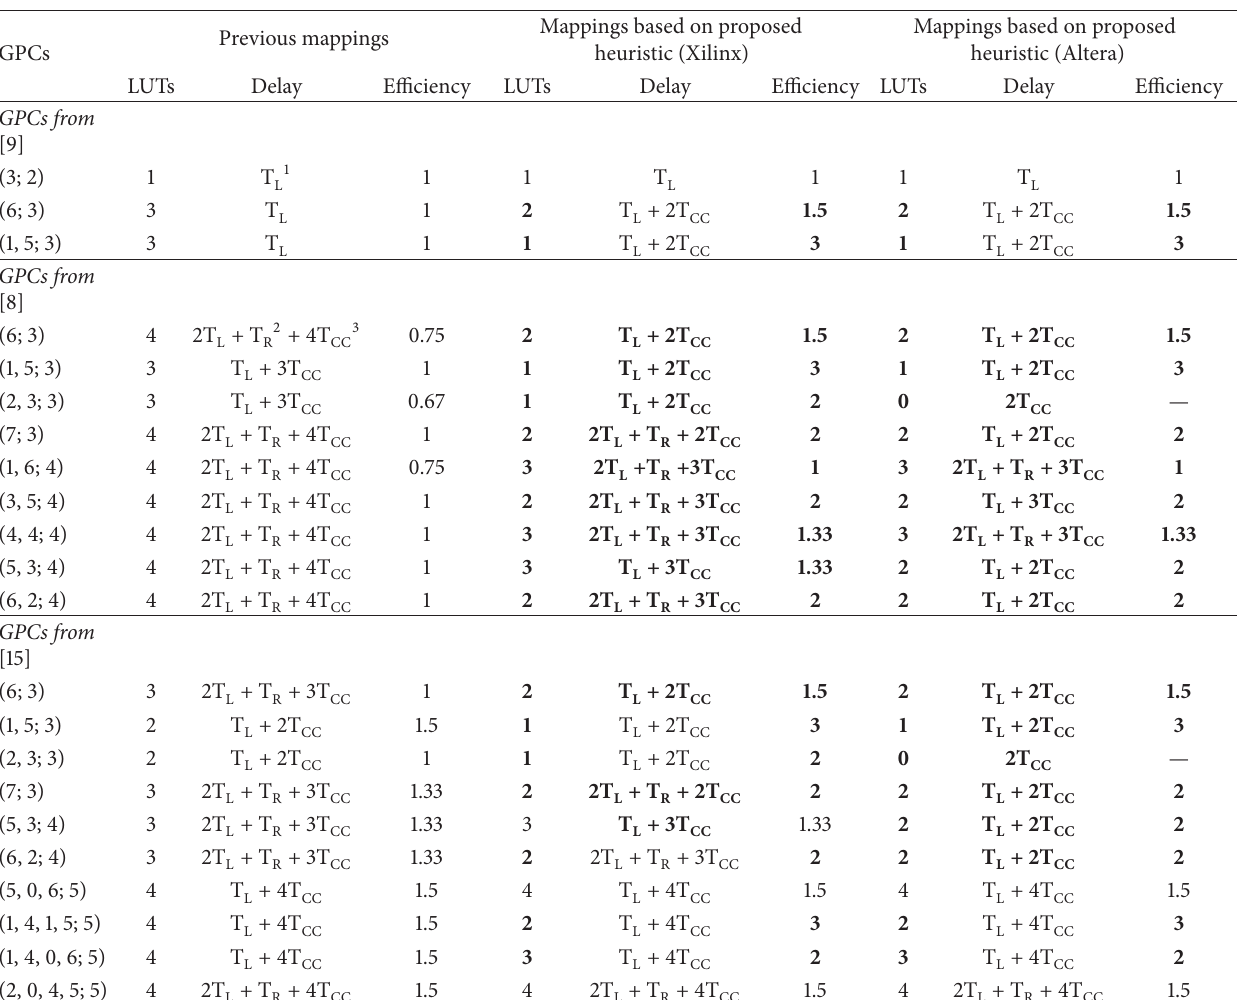
Table 1: Comparison of different